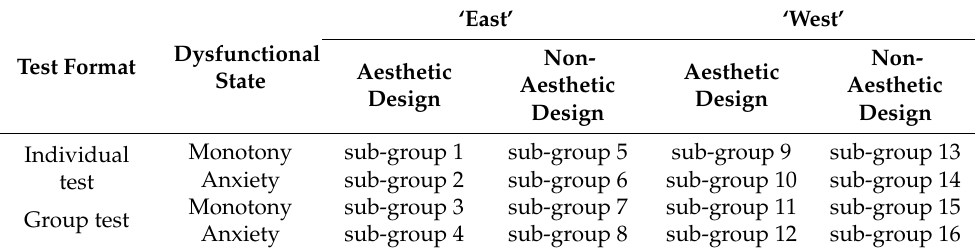
Table 1. The research design and assessor groups, 5 people per